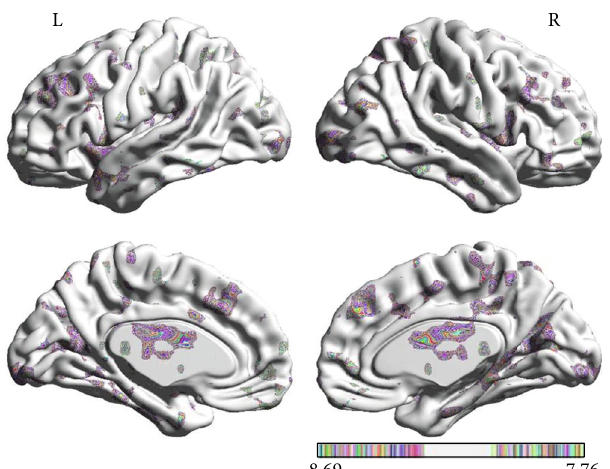
Figure 7: Regions showing signi fi cantly di ff erent EC with the rACC in placebo status compared with pain status (EG). Table 4: Locations of the regions showing signi fi cantly altered EC with the rACC in IG compared with EG in placebo status ( p < 0 : 05 , FDR < 0 : 05 ).